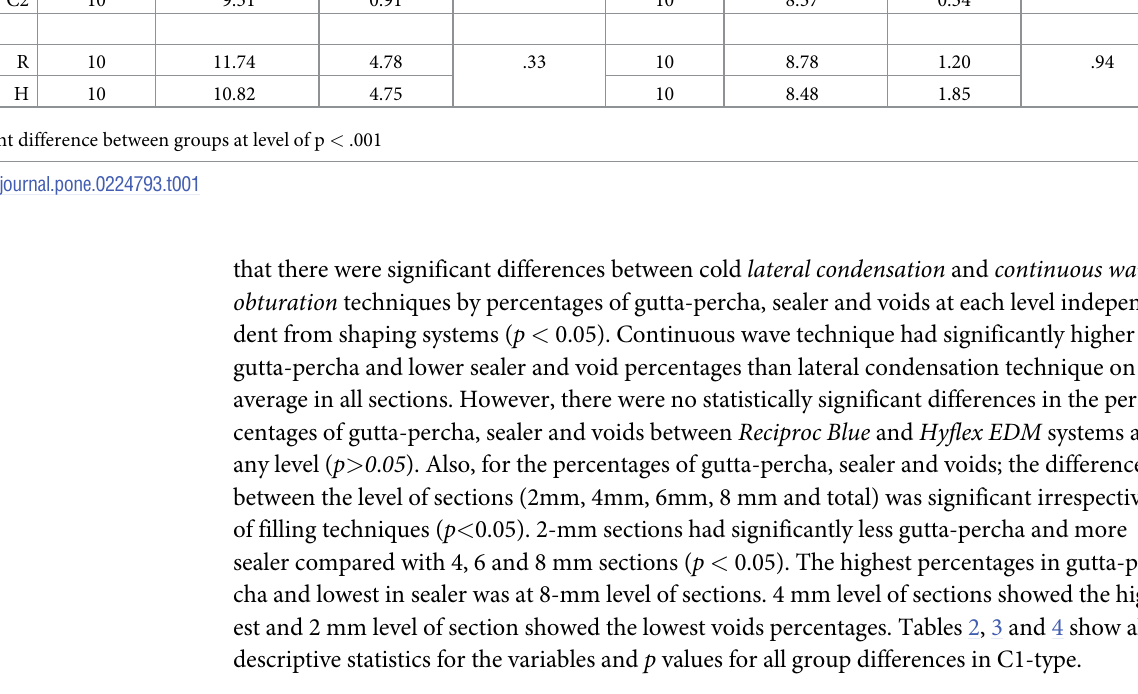
Table 2. Mann-Whitney U and Kruskal-Wallis tests results with descriptive statistics of C1-type’s median percentage values of gutta-percha, sealer and voids according to filling techniques, shaping system and level of sections. Gutta-Percha Sealer Voids n Median Median Filling